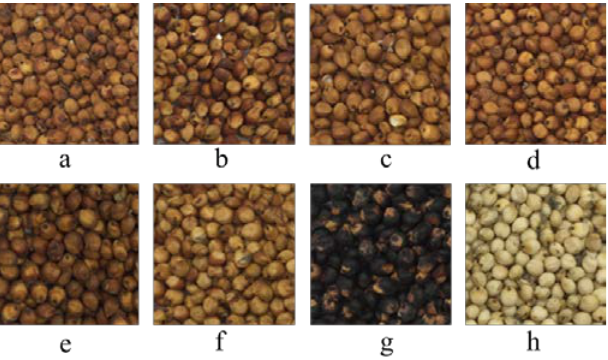
Figure 1. Pictures of the investigated sorghum grains. Letters ( a – h ) represent grains of S-1, S-2, S-3, S-4, S-5, S-6, S-7 and S-8, respectively. Table 1. The geographic information of the analyzed sorghum grains.